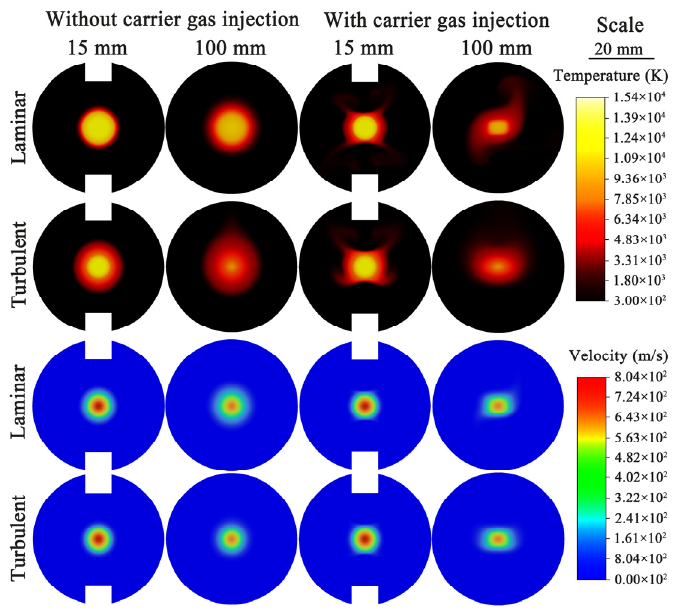
Figure 9. Temperature distribution and velocity distributions on different cross-sections of plasma jet.